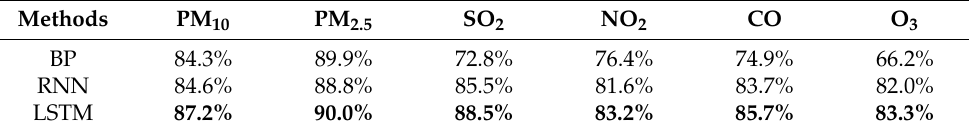
Table 8. The accuracies of LSTM network compared with traditional networks in dataset 1. Methods